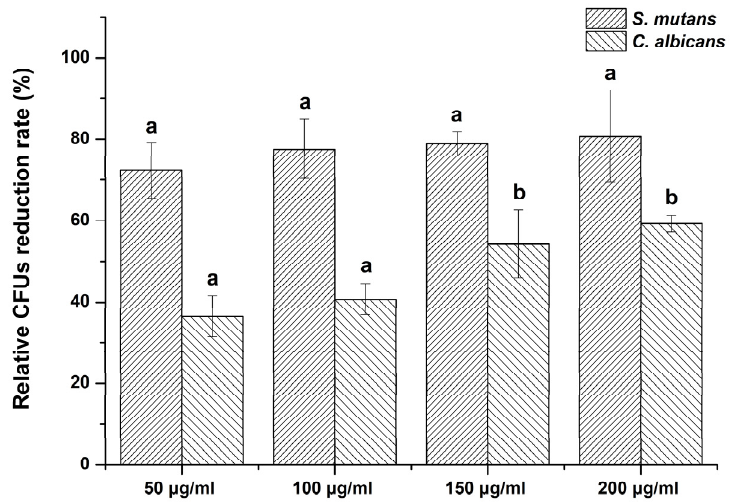
Figure 2. Relative colony-forming unit (CFU) reduction rate of two microbial strains following exposure to Glycyrrhiza uralensis extract with concentrations of 50, 100, 150, and 200 µg/mL. The same lowercase letter shows no significant difference in CFU reduction rate between the groups of a given microbe ( p > 0.05).